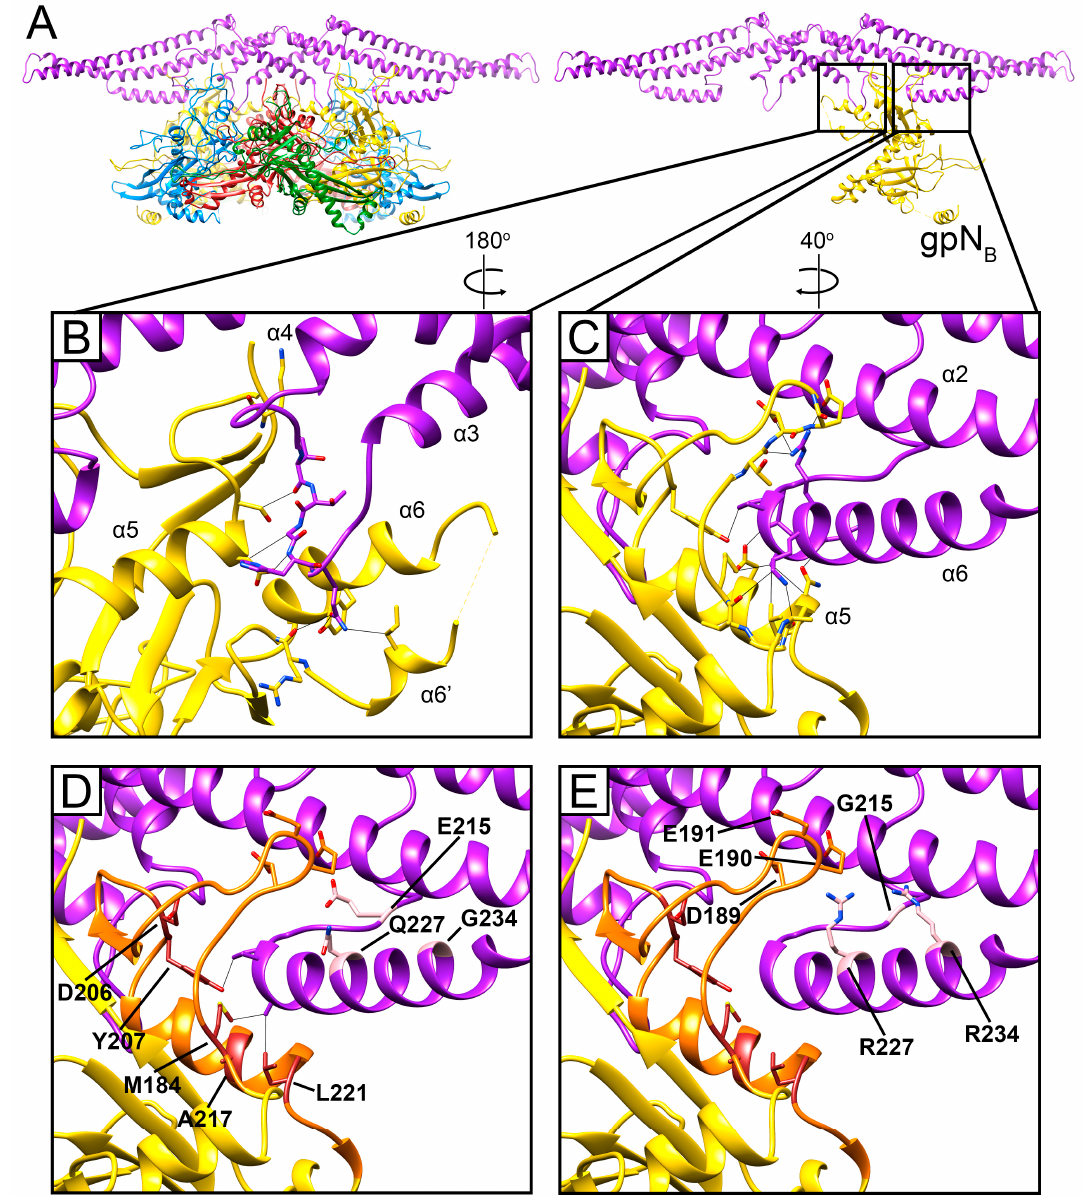
Figure 5. Sid-gpN interaction. ( A ) Ribbon diagram of the Sid dimer (purple) and the underlying gpN hexamer; subunits colored as in Figure 2. In the right panel, only gpN B is depicted. ( B ) Detail of the interaction between the Sid α 3– α 4 loop and gpN B . Residues that make contact are shown in stick representation, and contacts closer than 4 Å are shown as gray lines. ( C ) Interactions between the C-terminal helix α 6 of Sid and the gpN B sir loop. ( D ) Same view as ( C ). The sir loop is shown in orange, and the residues mutated in sir and nms mutations are labeled in. ( E ) Same view as ( D ), showing how nms mutations (E215G, Q227R, G234R) might facilitate novel charged interactions with gpN (residues D189, E190,